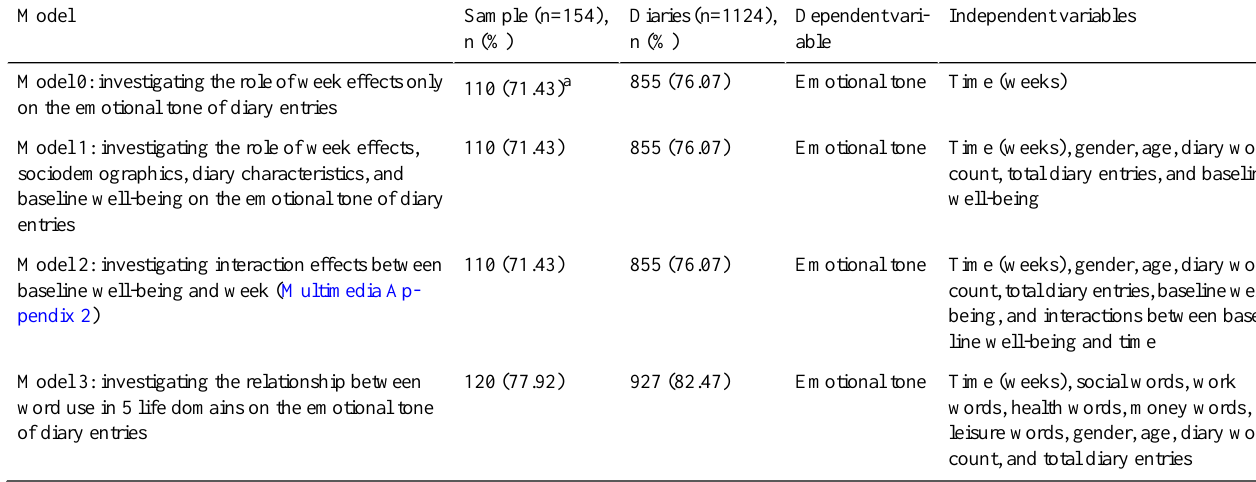
Table 1. Random effects generalized least squares with autoregressive disturbances regression models